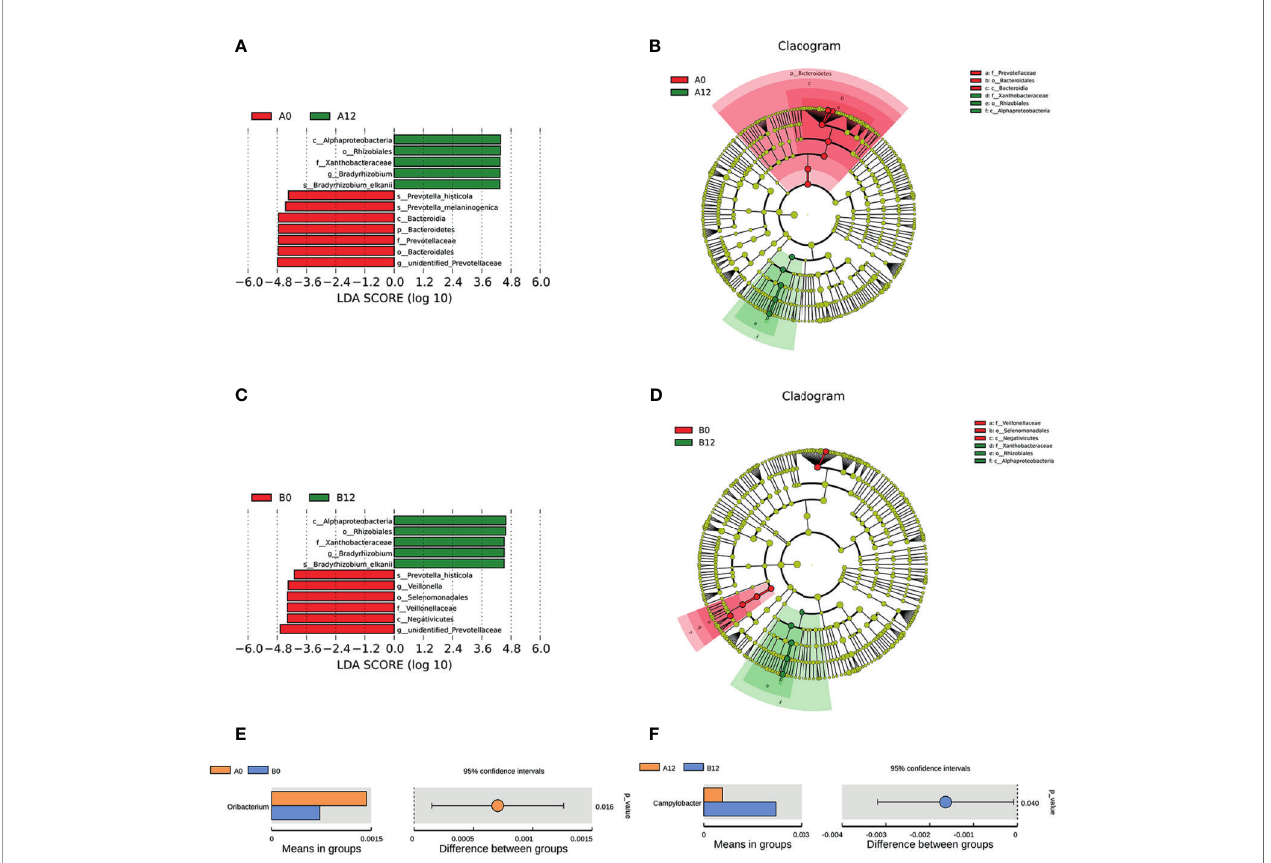
FIGURE 4 | Linear discriminative analysis (LDA) effect size (LefSe) at the genus level. (A, B) shown between A0 and A12 groups and (C, D) between B0 and B12 groups. In (A, B) , LDA scores for the signi fi cant taxa in A12 group are represented on the positive scale (green), and LDA-negative scores represent enriched taxa in A0 group (red); and in (C, D) , LDA scores for the signi fi cant taxa in B12 group are represented on the positive scale (green), and LDA-negative scores represent enriched taxa in B0 group (red). Comparisons of the relative abundance in oral microbiota at the genus level (E) Between A0 and B0 groups; (F) Between A12 and B12 groups. A0, people living with acute HIV infection at baseline; B0, people living with chronic HIV infection at baseline; D, HIV-uninfected controls; A12, people living with acute HIV infection after 12 weeks of ART; B12, people living with chronic HIV infection after 12 weeks of